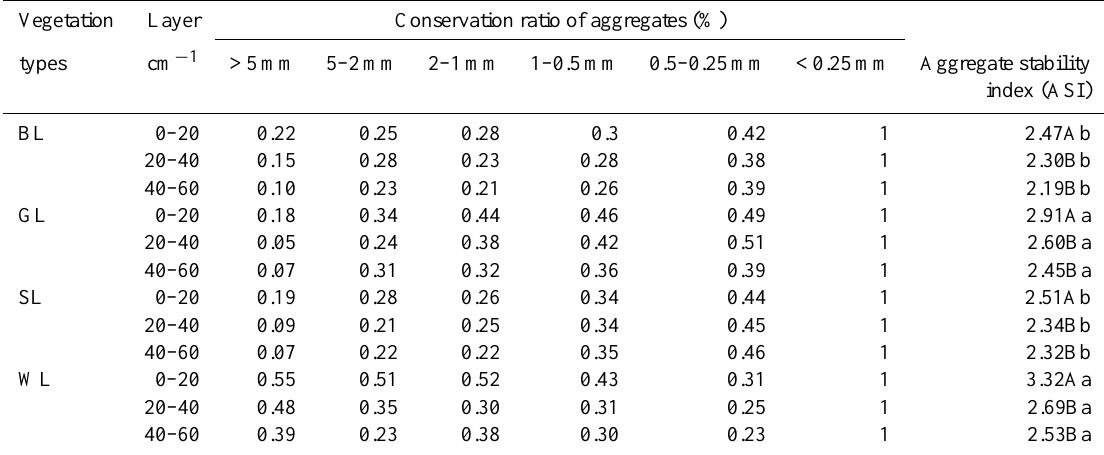
Table 4. Conservation ratio of aggregates and aggregate stability index.